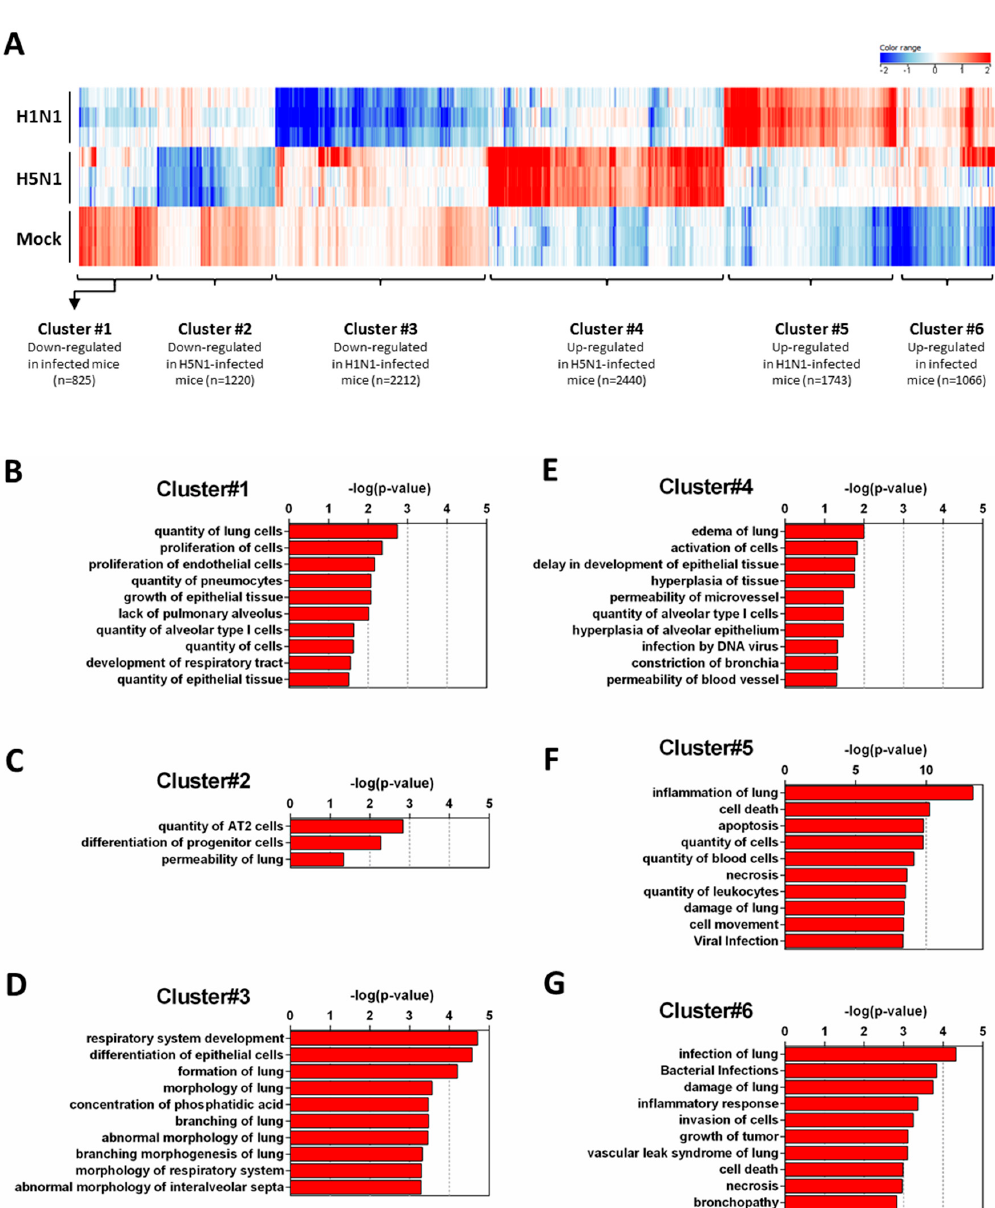
Figure 2. Functional relationships of pathways regulated during infection. Total RNA from mock-, H1N1-, or H5N1-infected C57Bl/6 mice were extracted from lungs at day 4 pi and used to hybridize Agilent’s Whole Mouse Genome Microarray (4 × 44K; G4122F). GeneSpring software (Version 13.0; Agilent Technologies) was used to analyze differences of gene expression between mock-infected mice and H1N1- or H5N1-infected mice. ( A ) Hierarchical clustering diagrams showing individual replicates are represented. The magnitude of the expression is illustrated by the intensity of the color. Red and blue indicate higher and lower expression level, respectively. ( B – G ) Molecular and cellular functions associated with differentially expressed genes were compared using IPA. Each cluster was separately analyzed and annotations were ranked using the p -value obtained using the right-tailed Fisher’s exact test, it represents the probability of each biological function to be involved in the group of analyzed genes.